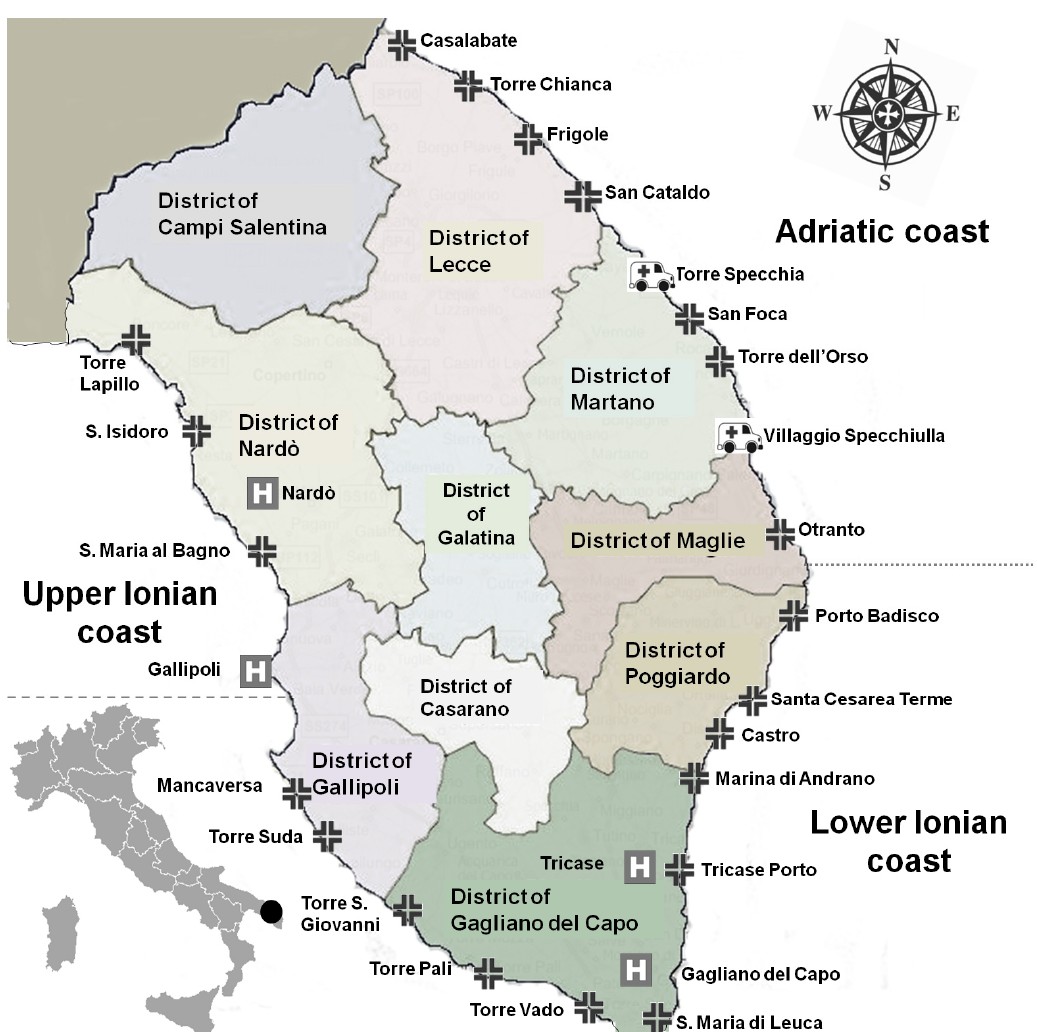
Figure 1. Health centres along the coast of the Salento peninsula (Italy). ( = Summer first aid centre, = Hospital, = emergency